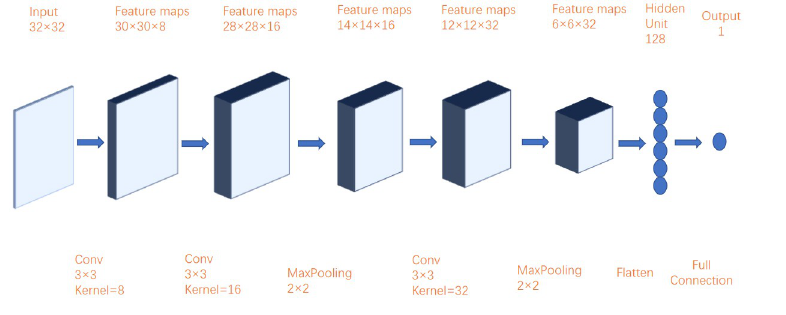
Fig 1. Convolution